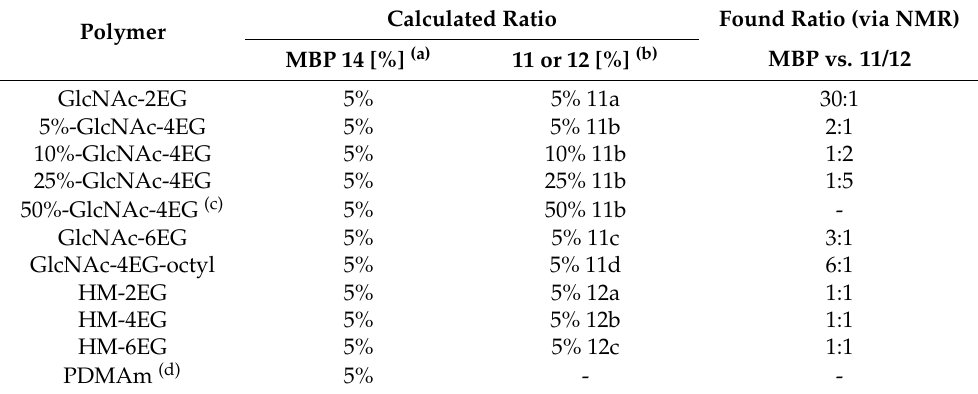
Table 1. Overview of the synthesized